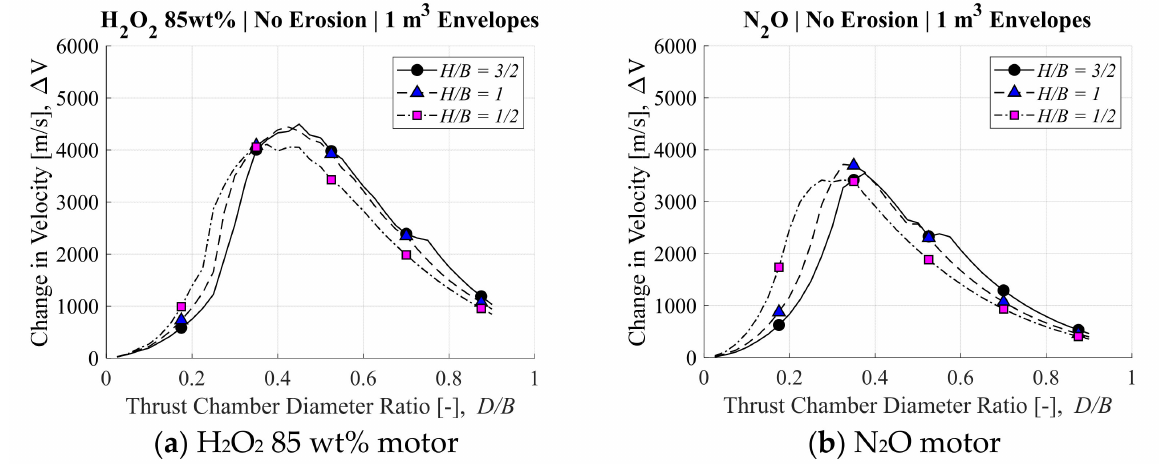
Figure 14. Realistic ∆ V solutions spaces for all three envelopes without nozzle throat erosion.